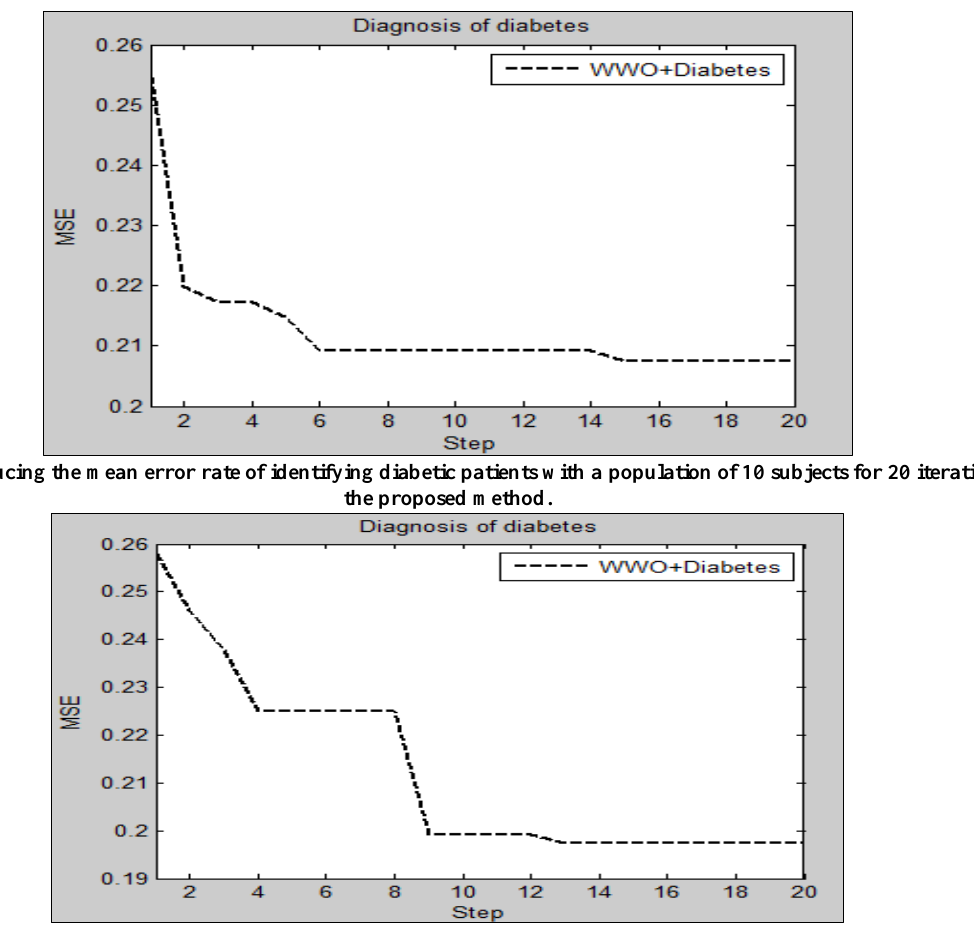
Figure 9. Reducing the mean error rate of identifying diabetic patients with a population of 20 subjects for 20 iterations in the proposed method.